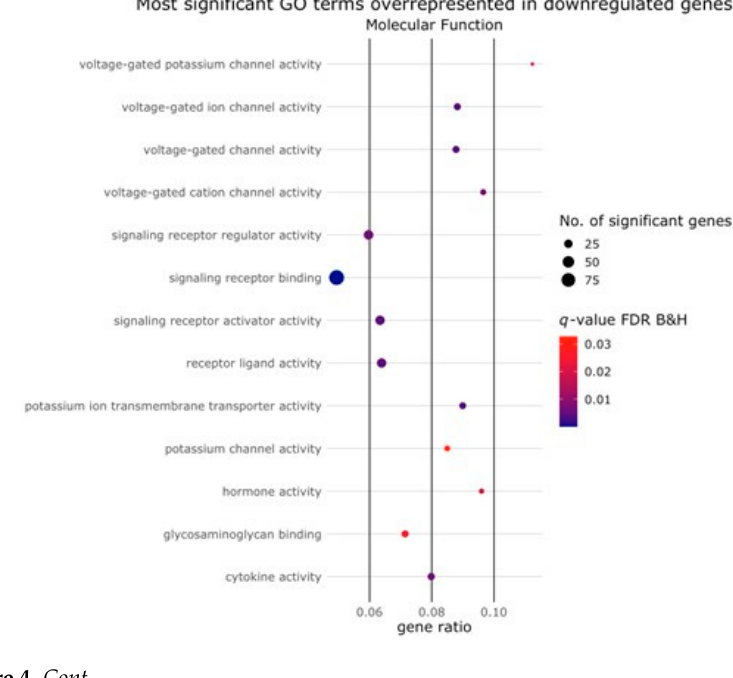
Figure 3. Gene Ontology terms enriched among the upregulated genes. Bubble plot showing Gene Ontology (GO) terms that were enriched among the genes upregulated by the Activin-A treatment. The size of the circle represents the number of DEGs ( p (adj) < 0.01, Log2 fold change ≥ 2) in that pathway. The color of the circle represents the significance depicted as the q-value, with the default settings of the Benjamini–Hochberg false discovery rate (FDR B&H). The gene ratio represents the ratio between the number of DEGs in our dataset and the total number of genes in that GO category. The top 20 most significant GO terms were enriched in ( A ) the molecular function domain, ( B ) the biological process domain and ( C ) the cellular component domain.